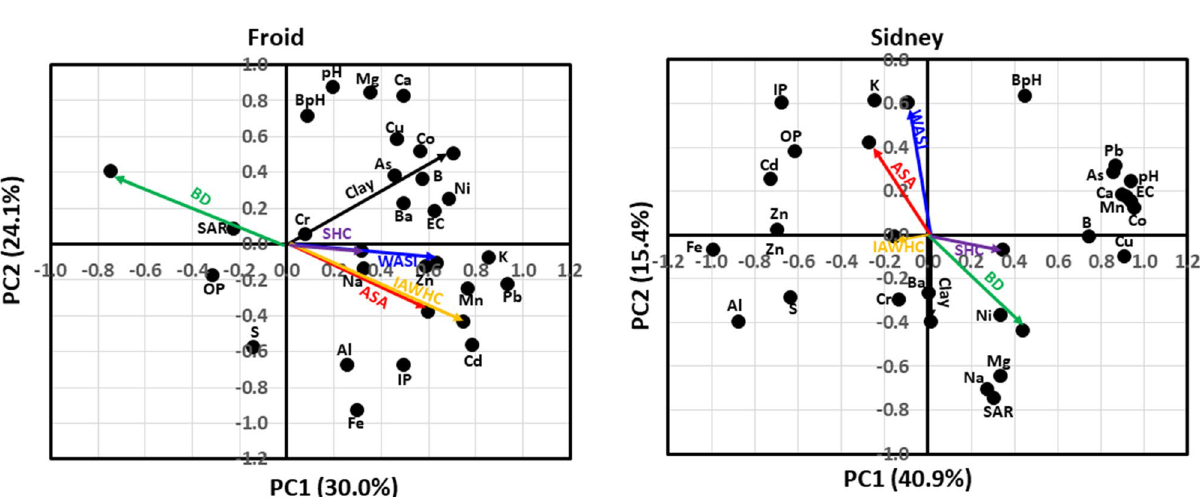
Figure 2. Principal component analysis for the associations among average slake aggregate (ASA), bulk density (BD), clay concentration, intact core available water capacity (IAWHC), saturated hydraulic conductivity (SHC), wet aggregate stability index (WASI), and soil chemical properties at Froid and Sidney, MT. At Froid, soil chemical properties explained 30.0% of the total variability in the first principal component (PC1) and 24.1% in the second principal component (PC2). At Sidney, chemical properties explained 40.9% of total variability in PC1 and 15.4% in PC2. BpH denotes buffer pH; EC, electrical conductivity; IP, inorganic P concentration; OP, organic P concentration; and SAR, sodium-absorption